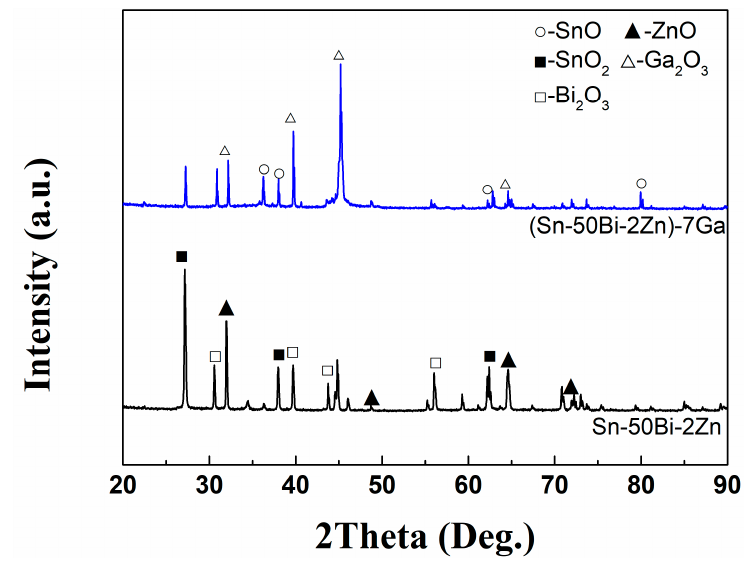
Figure 4. XRD patterns of oxide surfaces on the test alloys.